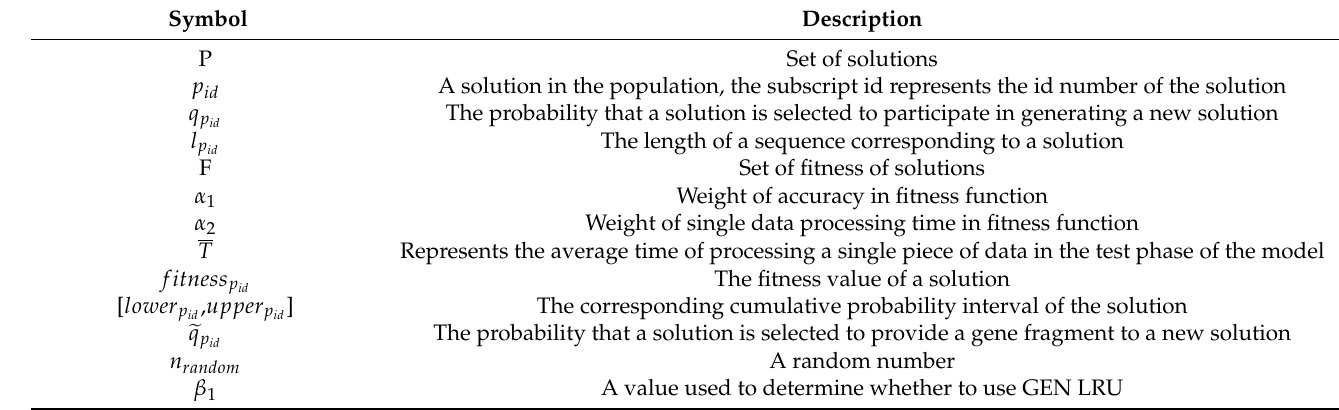
Table 1. Symbol table.